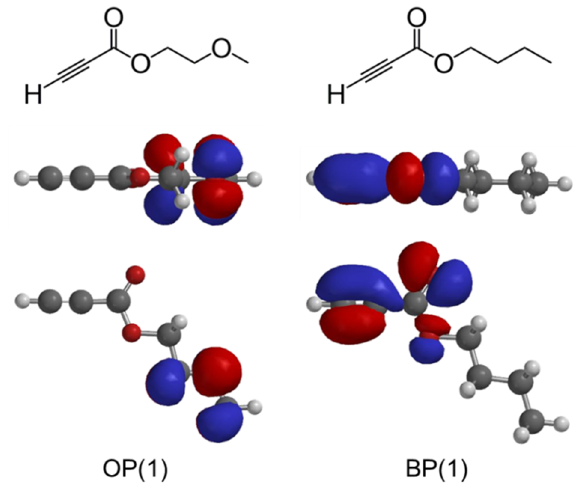
Figure 2. HOMO of OP(1) and BP(1) calculated using the DFT method (B3LYP/6-31G**).